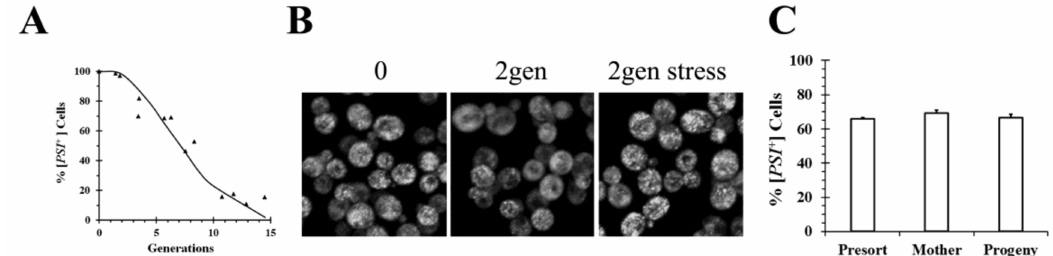
Figure 2. Curing of [ PSI + ] in SY80 yeast strain by overexpression of wild-type Hsp104. ( A ) Time course of curing [ PSI + ] as a function of generation time. ( B ) Images of the GFP-labeled foci in SY80 before induction, after 2 generations in galactose medium to induce Hsp104 expression, and 2 generations in galactose medium, followed by stressing the cells by starvation. ( C ) Flow cytometry analysis of curing of [ PSI + ] in 779-6a